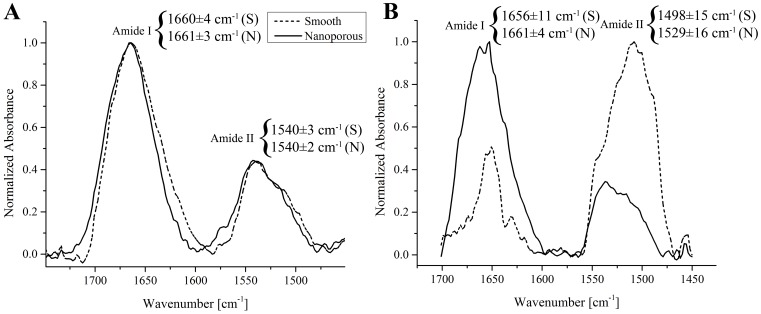
Representative examples of the FT-IR spectrum of bovine serum albumin (A) and vancomycin (B) adsorbed onto smooth (dashed line) and nanoporous (solid line) surfaces.The amide I and II maxima are indicated (S: smooth; N: nanoporous).